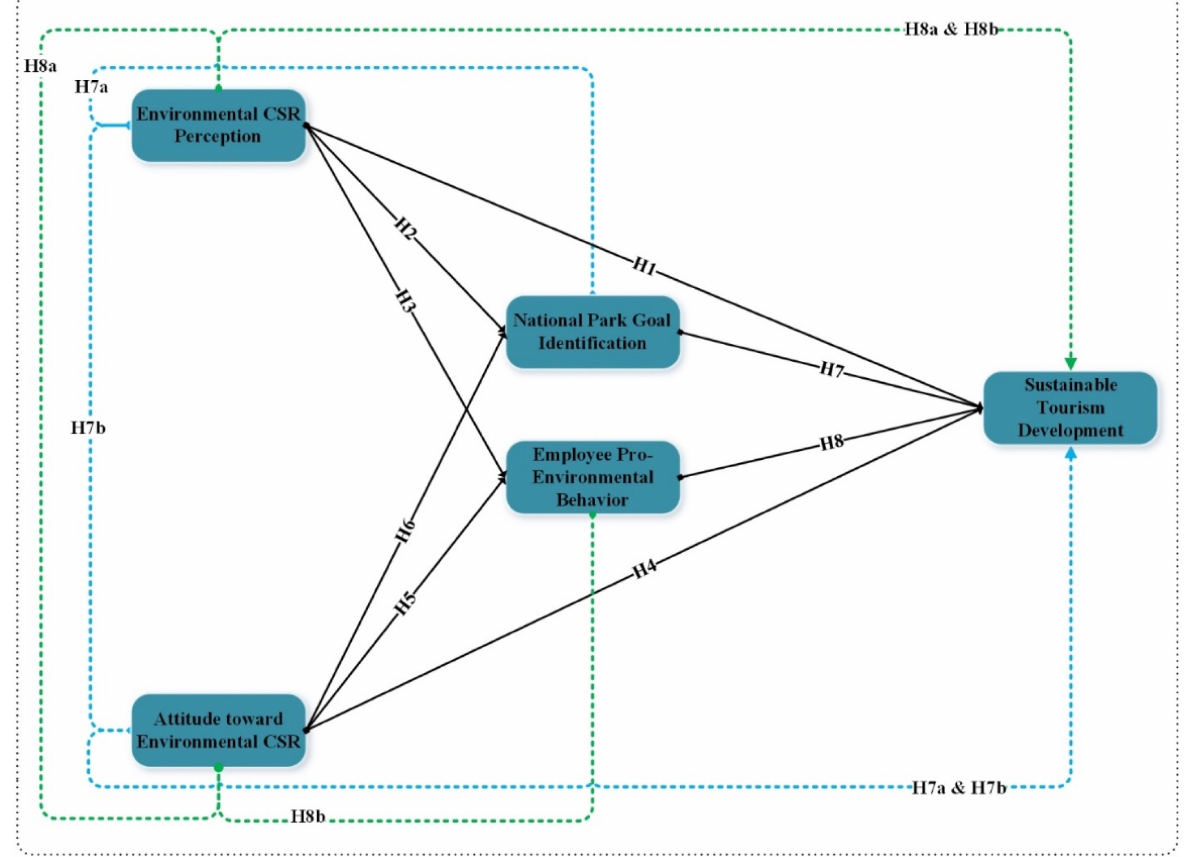
FIGURE 1 | Study conceptual